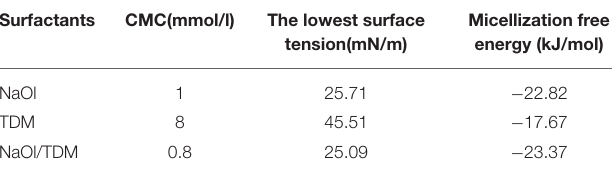
TABLE 1 | CMCs and related properties of NaOl, TDM, and NaOl/TDM.